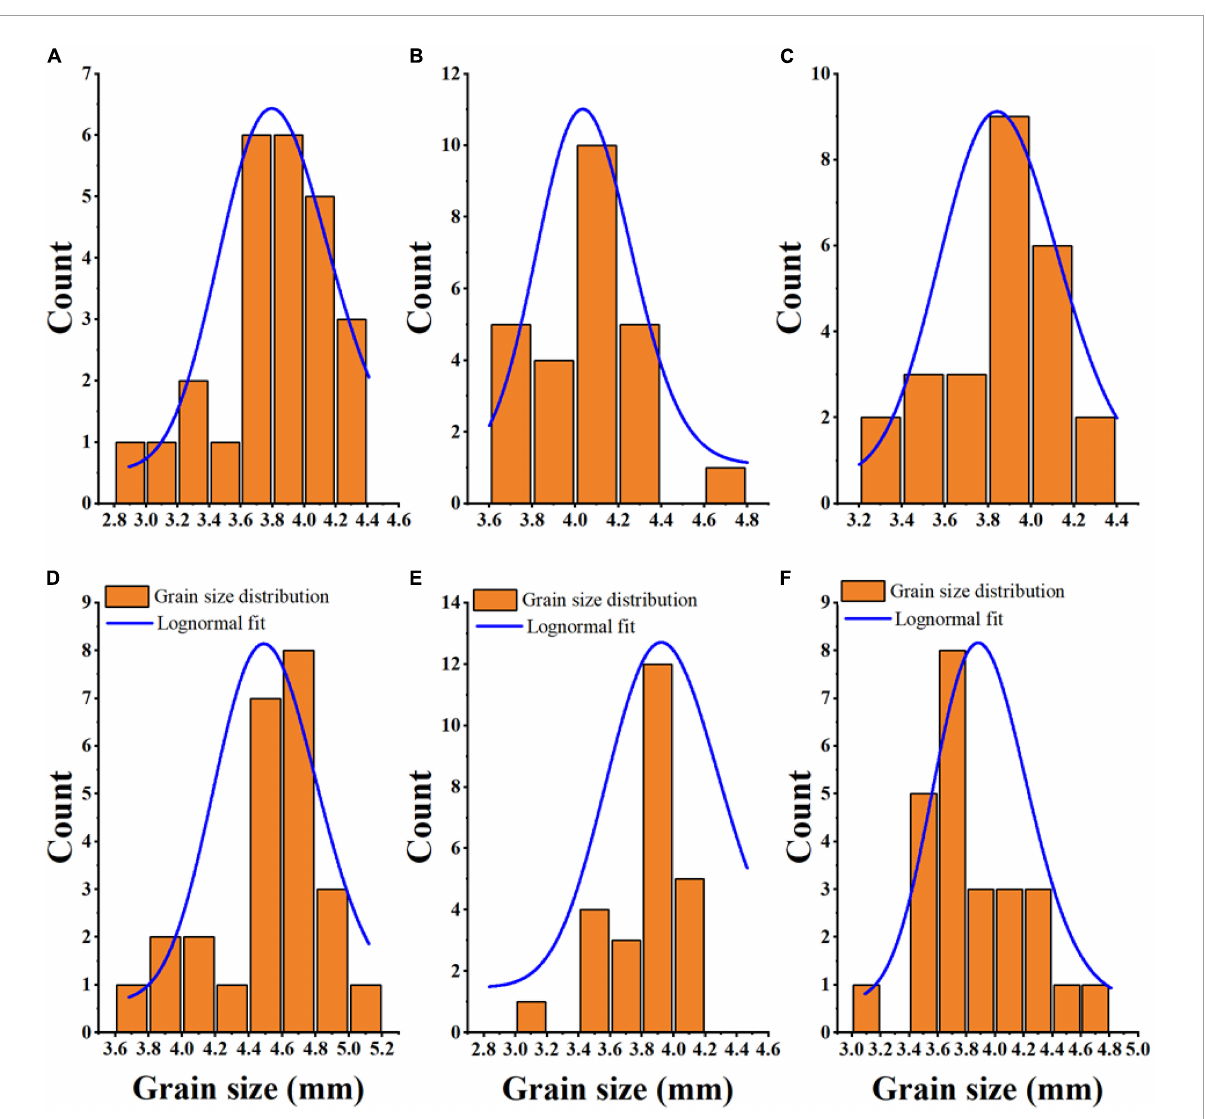
FIGURE1 Grain size distribution and Lognormal fitting of six sorghum grains. JZ 34, jinza 34 (A) ; LZ 19, liaoza 19 (B) ; JN 3, jinnuo 3 (C) ; JZ 127, jiza 127 (D) ; JN 2, jiniang 2 (E) ; JX, jiaxian (F)